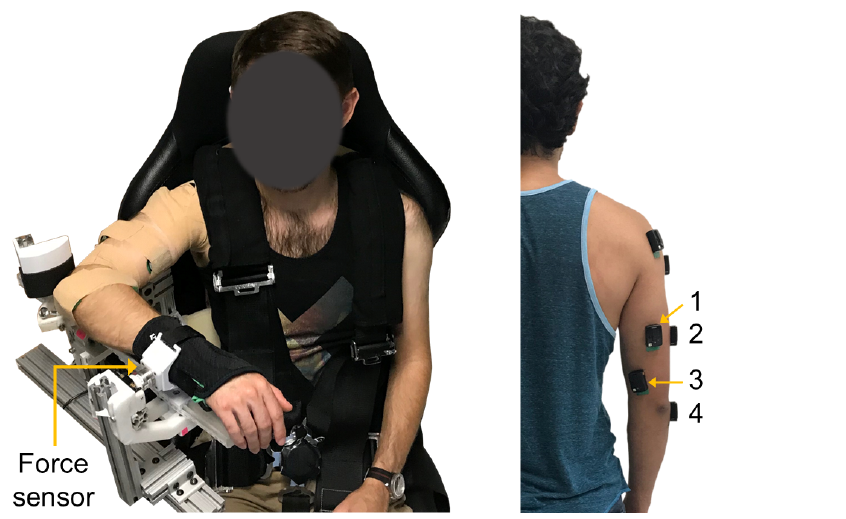
Figure 1. Experimental setup. ( Left ) Exoskeleton testbed. ( Right ) sEMG sensor placement: (1) long, (2) lateral, and (3) medial heads of the triceps brachii, and (4) anconeus